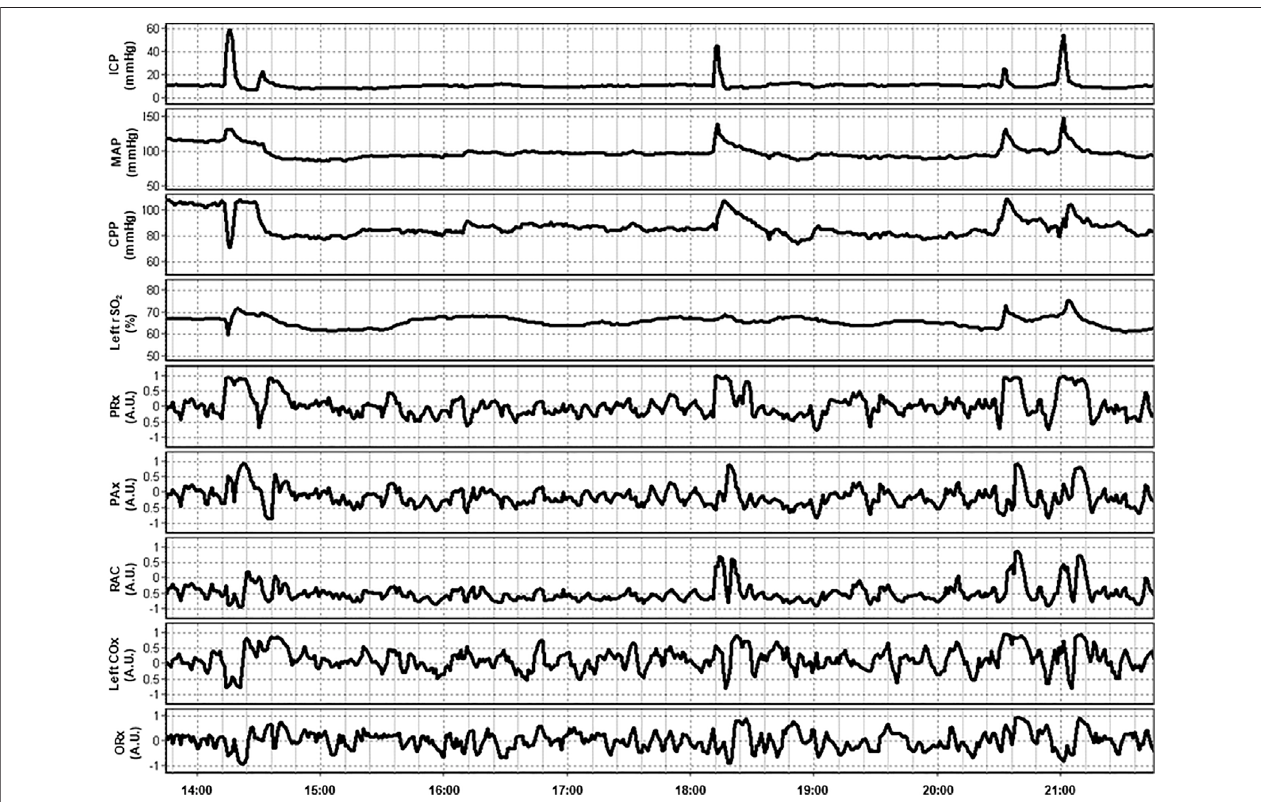
FIGURE 3 | An example of continuous 8-h recordings of intracranial pressure (ICP), mean arterial pressure (MAP), cerebral perfusion pressure (CPP), and regional cerebral oxygen saturation (rSO 2 ) in a traumatic brain injury patient. Also demonstrated are continuous ICP-based (PRx, PAx, and RAC), near-infrared spectroscopy (NIRS) based(COx),andbraintissue oxygenation(PbtO 2 )based(ORx)indicesofcerebrovascularreactivity.Datatakenfrompreviouslypublishedandapproved studies (University of Manitoba REB: H2017:181, H2017:188 and H2020:118; Bernard et al., 2020; Froese et al., 2020b; Froese et al., 2020a; Froese et al., 2021; Thelin et al.,